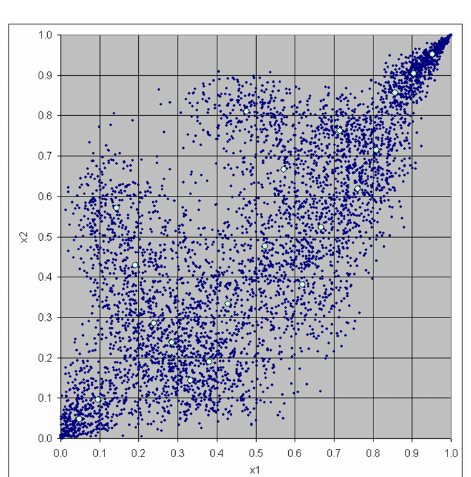
Figure 22: Gamma copula with UF copula driver, Figure 23: Gamma copula with UF copula